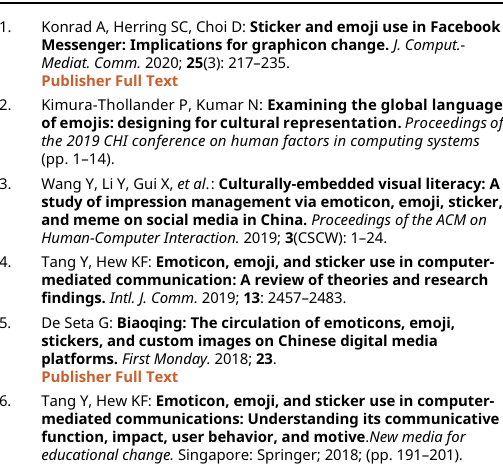
This project contains the following extended data: